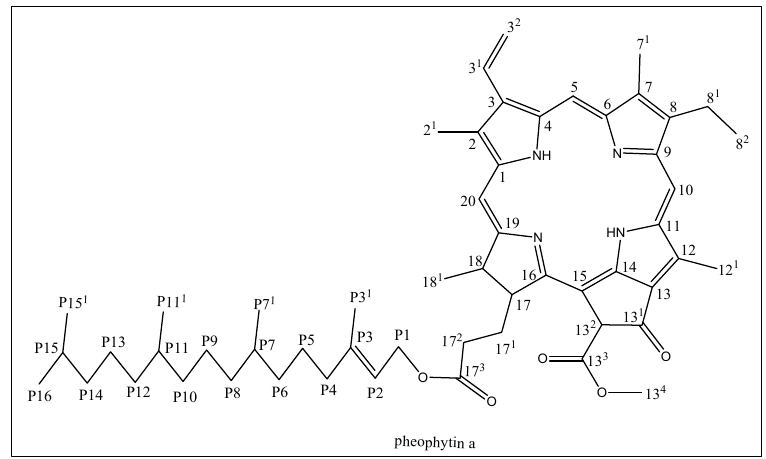
Figure 1. Chemical structure of pheo-a.